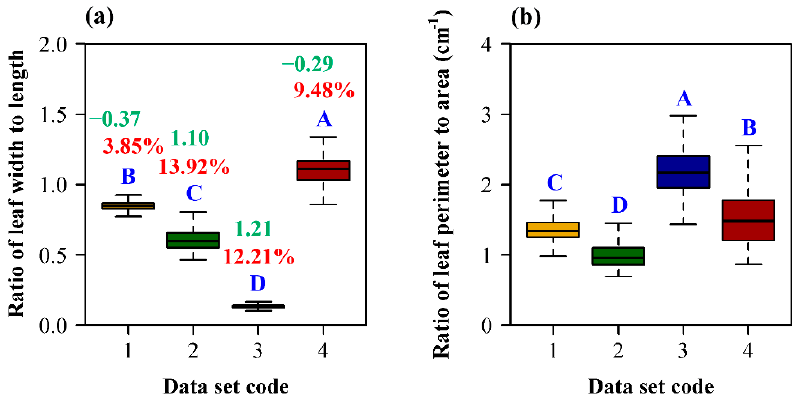
Figure 5. Comparison of the ratios of leaf width to length (and the ratios of leaf perimeter to area) among the four species of plants. ( a ) The ratio of leaf width to length; ( b ) the ratio of leaf perimeter to area. In panel ( a ), the red percentage number above the box is the coefficient of variation of the ratios of leaf width to length; the green number above the box is the skewness of the ratios of leaf width to length. The letters A, B, C, and D in each panel were used to indicate a significant difference of species means using Tukey’s HSD ( α = 0.05). Data set 1 represents H. vulgaris ; data set 2 represents G. biloba ; data set 3 represents O. sulcatum ; data set 4 represents P. perfoliatum .